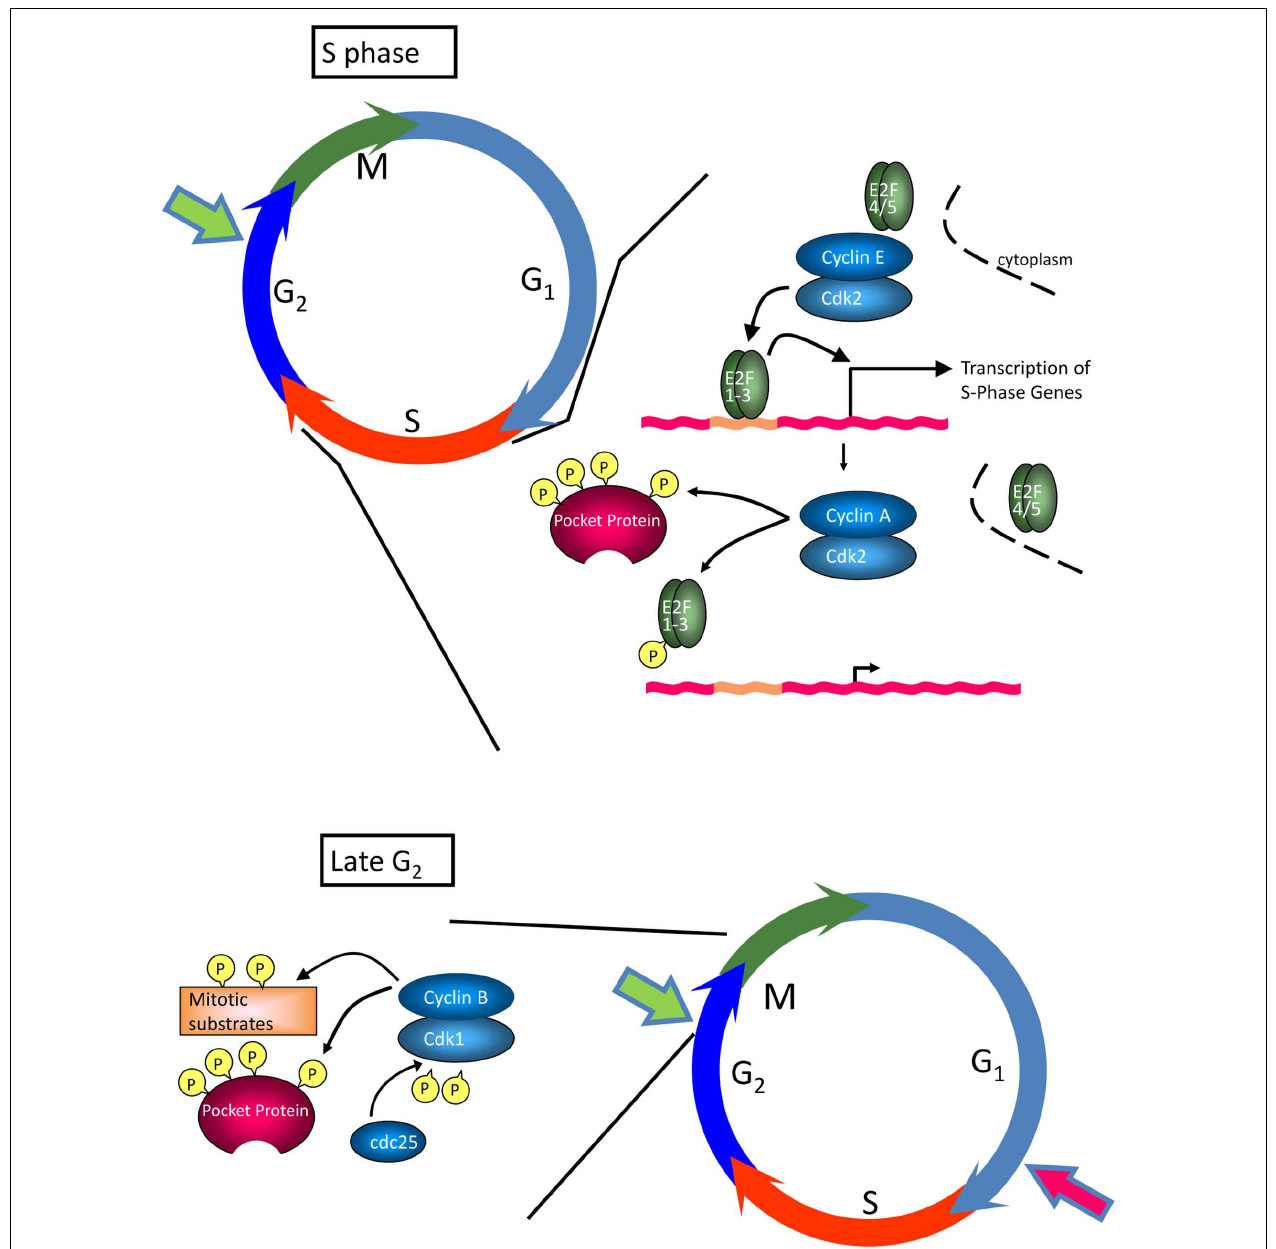
FIGURE 1 |The cell cycle. The cell cycle consists of four phases, G1, S, G2, and M. In early G1, hypophosphorylated pRb binds the E2F transcription factor, and recruits histone deacetylase (HDAC) and other factors to actively repress transcription of E2F-regulated genes important for transition into S phase and DNA replication (e.g., PCNA, topoisomerase I, c-Myc, cyclin E, Cdc25c). Progression through early G1 is dependent on growth factors, which promote expression of D-type cyclins. Formation of cyclin D/cdk4 and cyclin D/cdk6 complexes, which is facilitated by Cip/Kip ckis, leads to phosphorylation of pRb at a subset of available sites and release of HDAC and other inhibitory factors, relieving repression of E2F and promoting upregulation of cyclin E. Cyclin E/cdk2 complexes, relieved from repression by Cip/Kip ckis by sequestration of these inhibitory molecules in cyclin D/cdk complexes, complete pocket protein phosphorylation in mid to late G1, enabling a wave of E2F-dependent transcriptional activity essential for S progression.Together, these events drive cells through the restriction